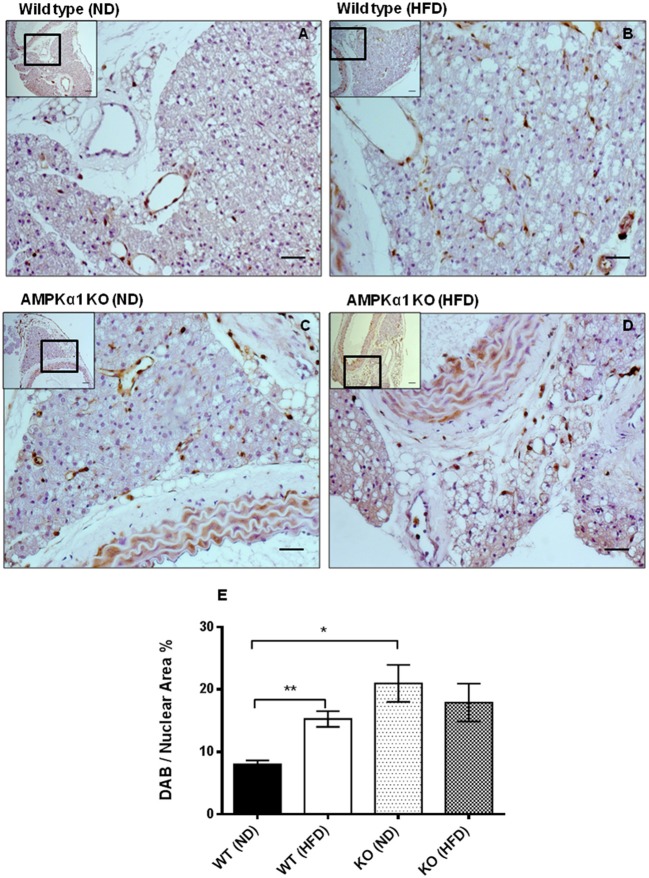
Effect of high-fat diet on macrophage marker (MAC2) expression in thoracic aortic PVAT. Aortic rings from wild type mice (A,B) and AMPKα1 knockout mice (C,D) were harvested from mice fed normal diet (ND) (A,C) or high fat diet (HFD) (B,D) and immunostained with anti-MAC2 antibody with haematoxylin counterstain. Scale bar = 20μm. Images shown are representative of at least n = 5 separate animals per group. (E) Histogram showing quantitation of immunostaining data. Data were expressed as percentage of stained cells to total nuclear area in the section. **p <0.01 vs WT (ND); *p < 0.05 vs WT (ND).